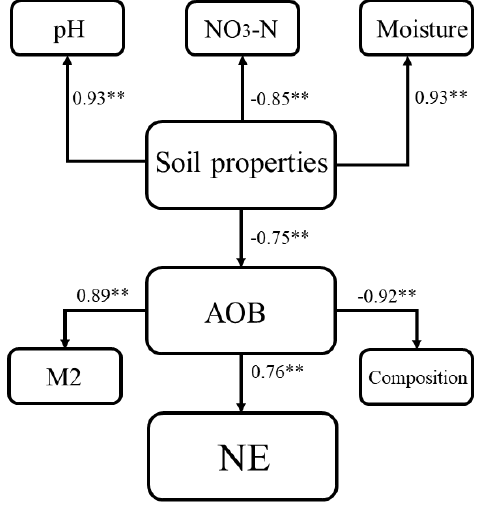
Figure 10. Structural equation modelling of ammonia-oxidizing bacterial communities with variability in soil properties. Significant levels are denoted: ** p < 0.01. Standardized total effects (direct and indirect effects) calculated by SEMs are displayed.